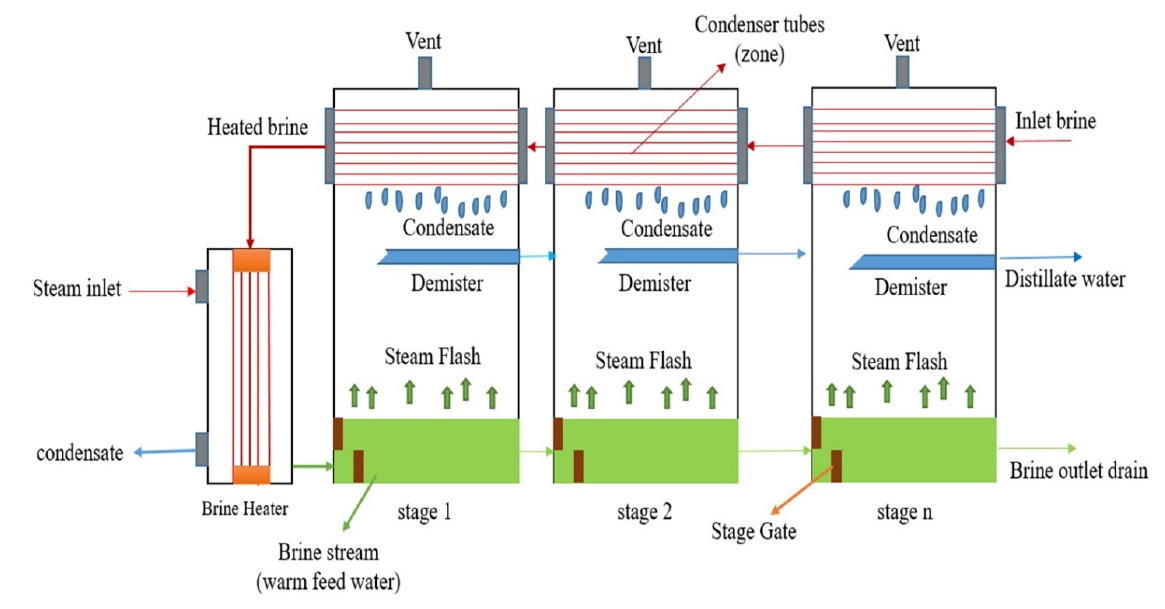
Figure 2. Once-through multi-stage